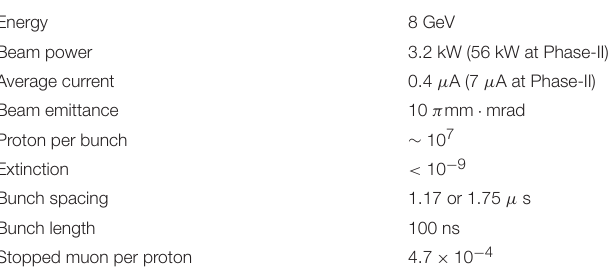
TABLE 2 | Proton beam specifications in COMET Phase-I